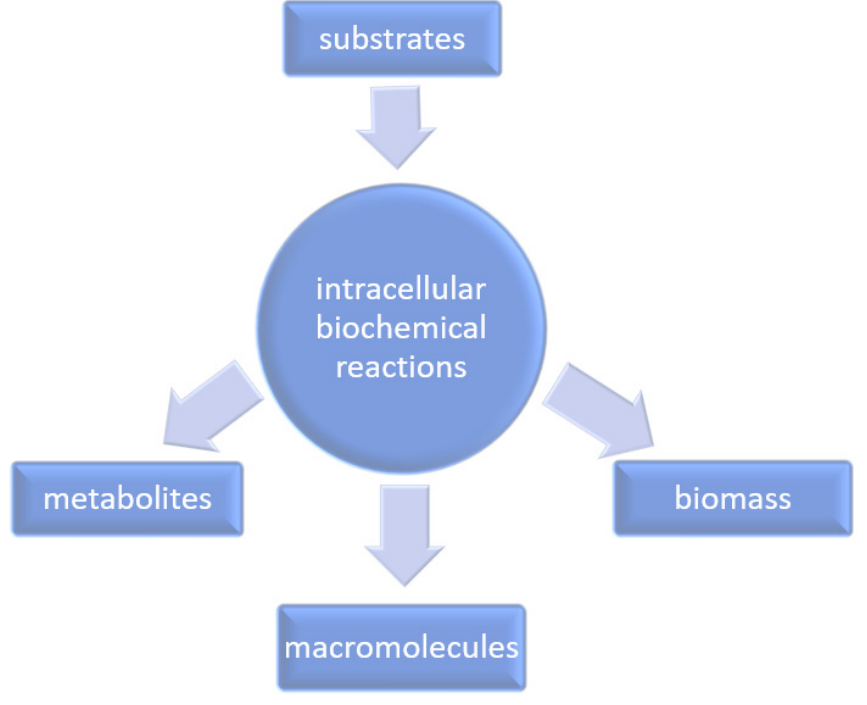
Figure 2. Scheme of the cell growth.